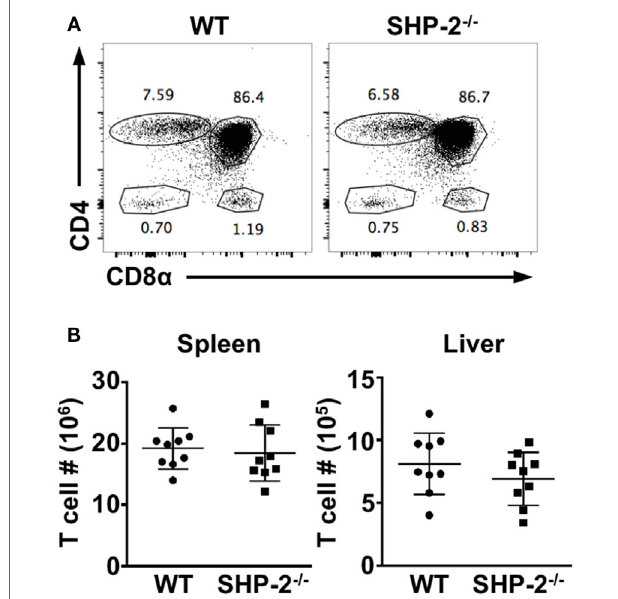
FigUre 2 | T cell development is mostly normal in SHP-2 − / − LCK-Cre mice. (a) Representative FACS plots show thymic T cell development in wild-type (WT) and SHP-2 − / − mice. (B) Number of T cells in the spleen and liver of SHP-2 − / − mice and littermate controls. Data are pooled from three independent experiments, n = 9. Error bars indicate